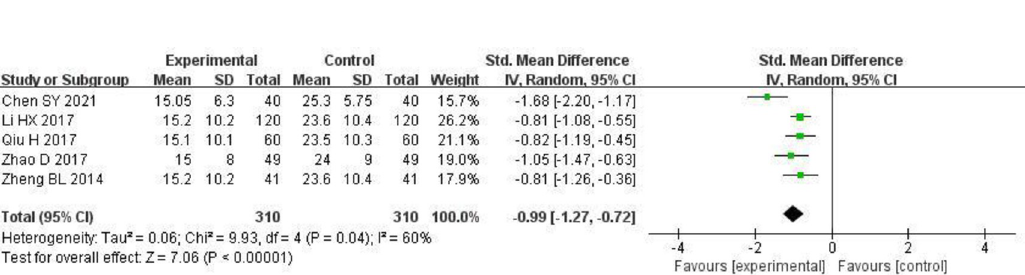
Fig 6. Forest plot of effects of Shenyankangfu tablets and Losartan potassium in the treatment of chronic glomerulonephritis on blood urea nitrogen.